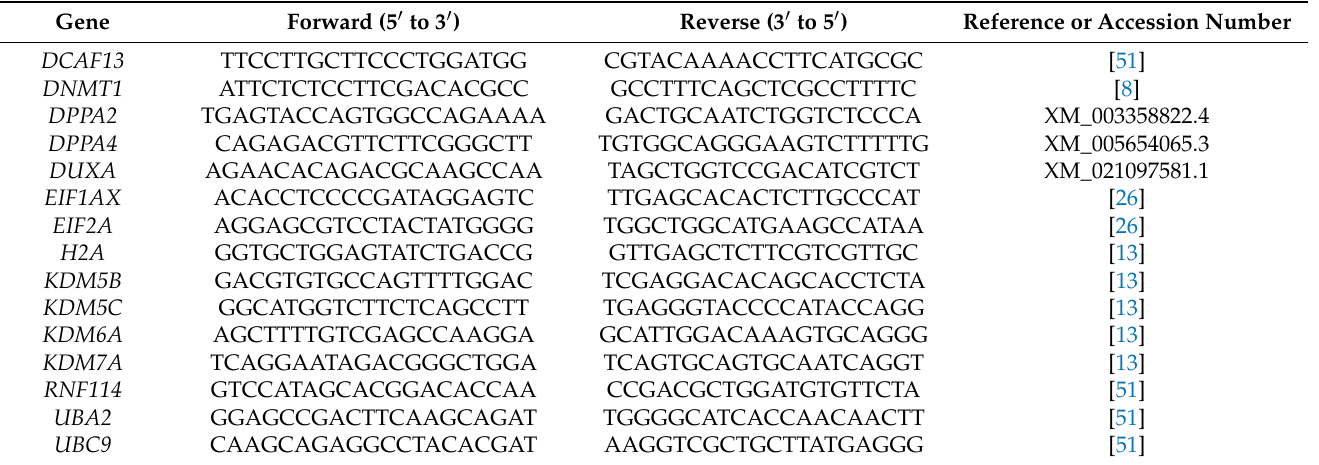
Table 2. Primers used in the quantitative real-time PCR